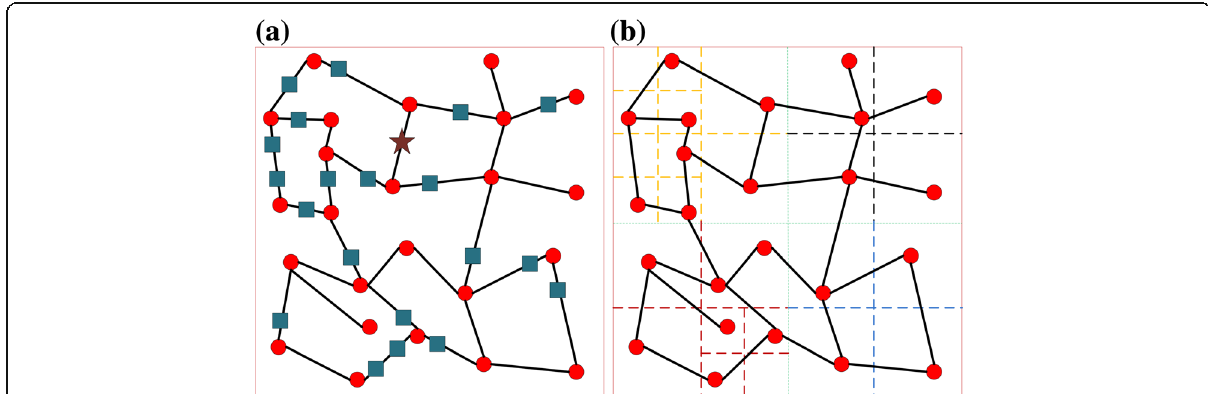
Fig. 3 Our partitioning method for a road network. a A sample of road network. b Partitioned road network. a A sample of road network. b A partitioned road network. In a , solid dots represent nodes, which can be viewed as intersections in the road map, and the edges between the two nodes are treated as road